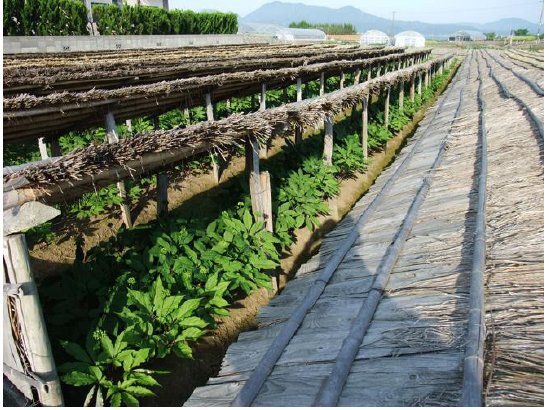
Figure 2. Covered hut for the cultivation of ginseng made of chestnut posts and a wheat straw roof.